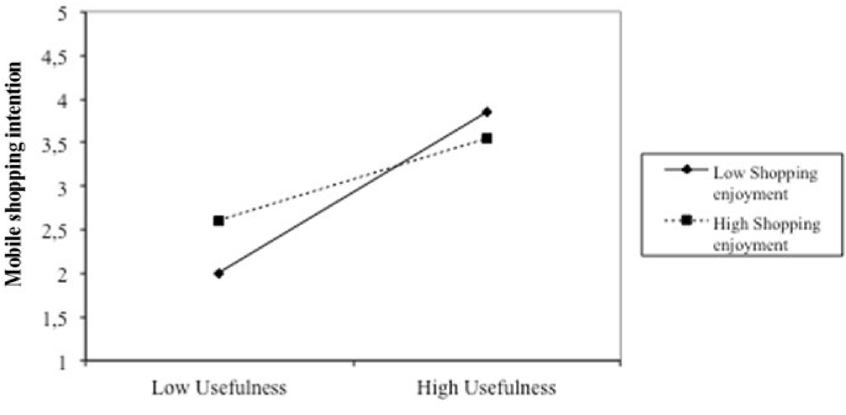
Figure 2. Relationship between